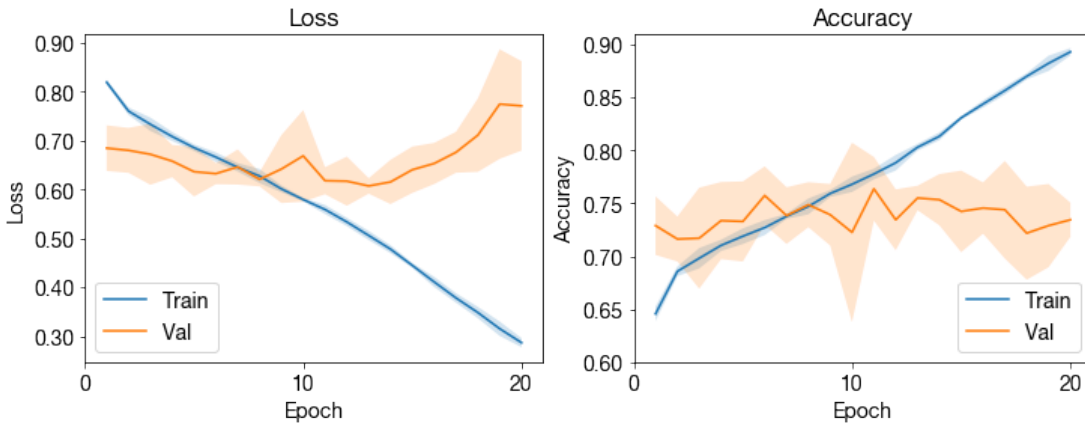
Figure A12. 1D CNN loss and accuracy across training